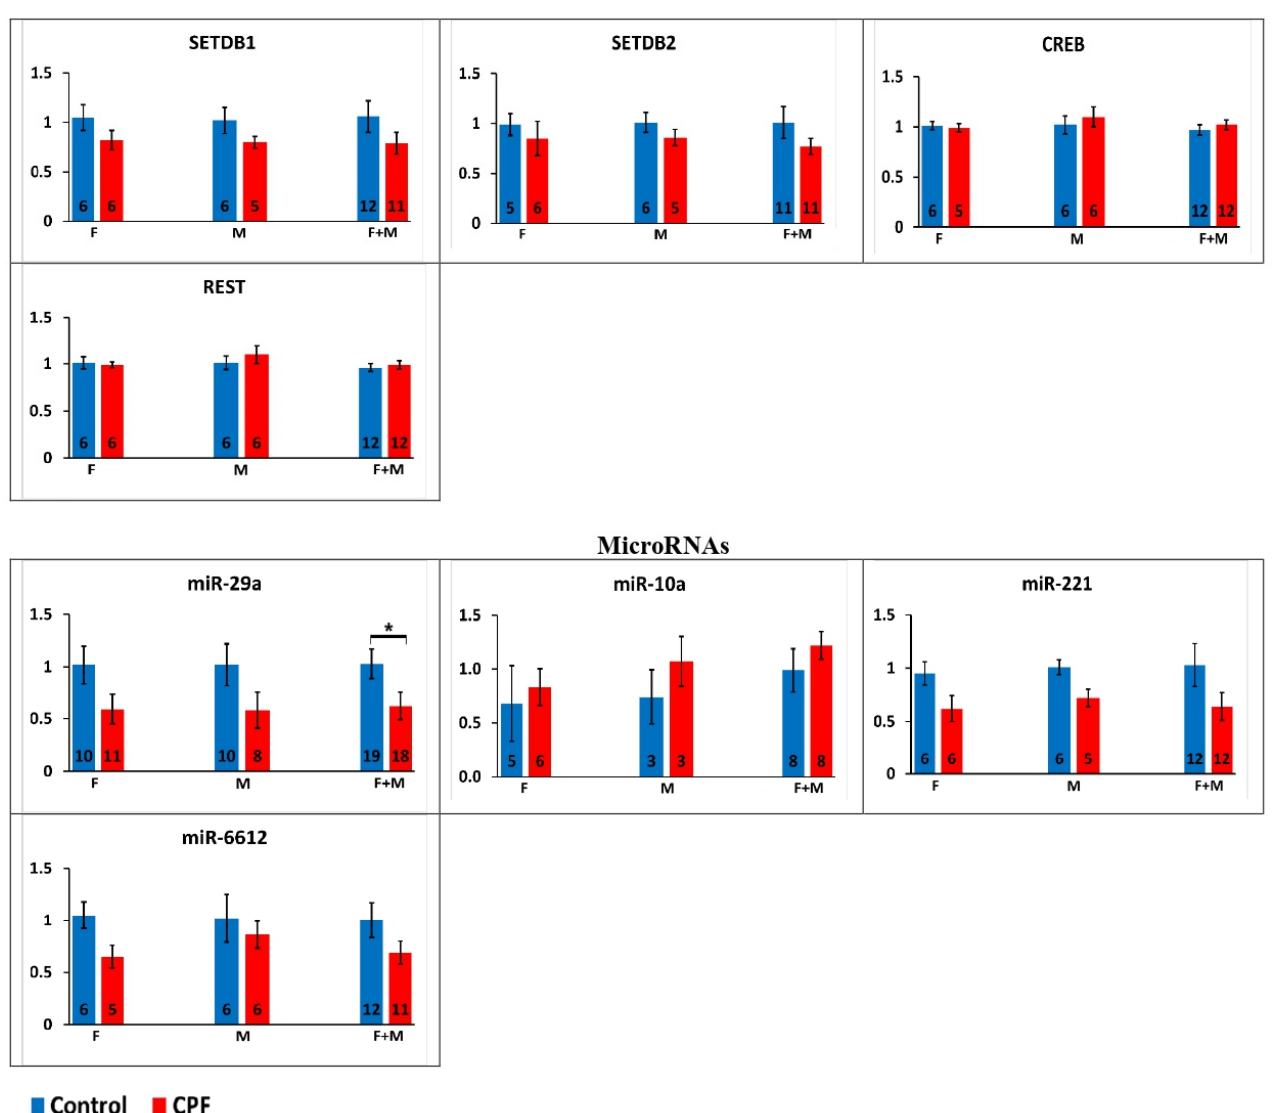
Figure 2. Effects of maternal preconception exposure to chlorpyrifos (CPF) on the offspring’s gene expression. Relative gene expression results obtained in the offspring after pre-hatch exposure to chlorpyrifos. M: male offspring, F: female offspring. Number of samples (n) is presented inside each column. Results are presented as the mean ± SEM. #: PKCß, which is related to both neurogenesis and neurotransmission genes, is presented in the neurotransmission section. *: p < 0.05. For genes abbreviations, please refer to Figure 1.